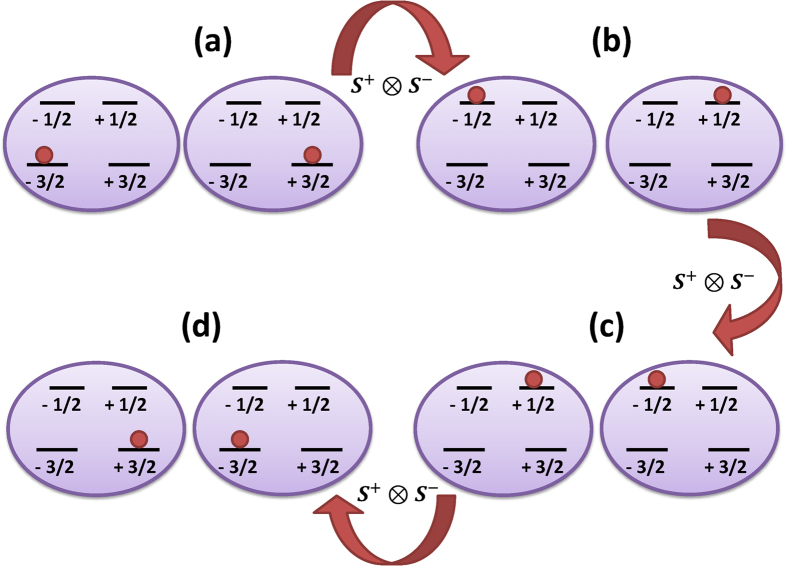
The third order effective hopping term in the memory-subspace.The third-order effective hopping Hamiltonian in the low-energy subspace can be explained by the application of  (with S± = Sx ± iSy), which arises in the third order perturbation theory used for getting the effective Hamiltonian (see Supplementary Material for more details). In fact, the three consecutive operations of the term  result in spin swap in the low-energy subspace through virtually populating the high-energy states. We show the states , for n = 0 (a), n = 1 (b), n = 2 (c), n = 3 (d), which are populated during the process.